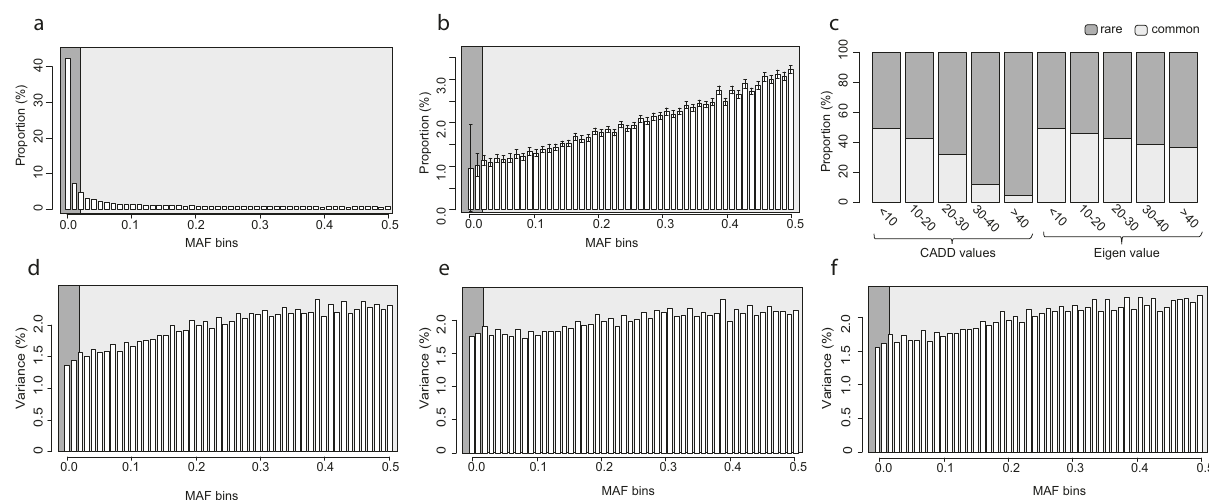
Fig. 1 Distribution of MAF, CADD/Eigen values, and fraction of variances across MAF-bins for SNVs and indels. In all fi gures, the dark grey area indicates the rare variants, as de fi ned in our analyses (MAF < = 0.0239), and the light grey indicates the common variants (MAF > 0.0239). a The MAF distribution of the variants identi fi ed in the NSPHS. The bars represent the proportion of variants with a MAF within each frequency bin. b Distribution of per sample allele counts for different MAF-bins. The bars represent proportion of alleles per sample belonging to different MAF-bins. Averages across all samples ( N = 1021 with WGS data were used to derive statistics) are shown and the error bars represent the 95% width of the distribution in the cohort. c The fraction of the SNVs and indels being rare vs. common, for different CADD and Eigen values. d The proportion of genotype variance that can be attributed to variants within the MAF-bins. Each bar represents the sum of all genotype variances for variants with the MAF-bin divided by the sum of genotype variances across all variants. e , f Proportion of additive genetic variance (narrow-sense heritability) that can be attributed to variants in different MAF-bins when allelic effect sizes are weighted by e CADD values and f Eigen values.